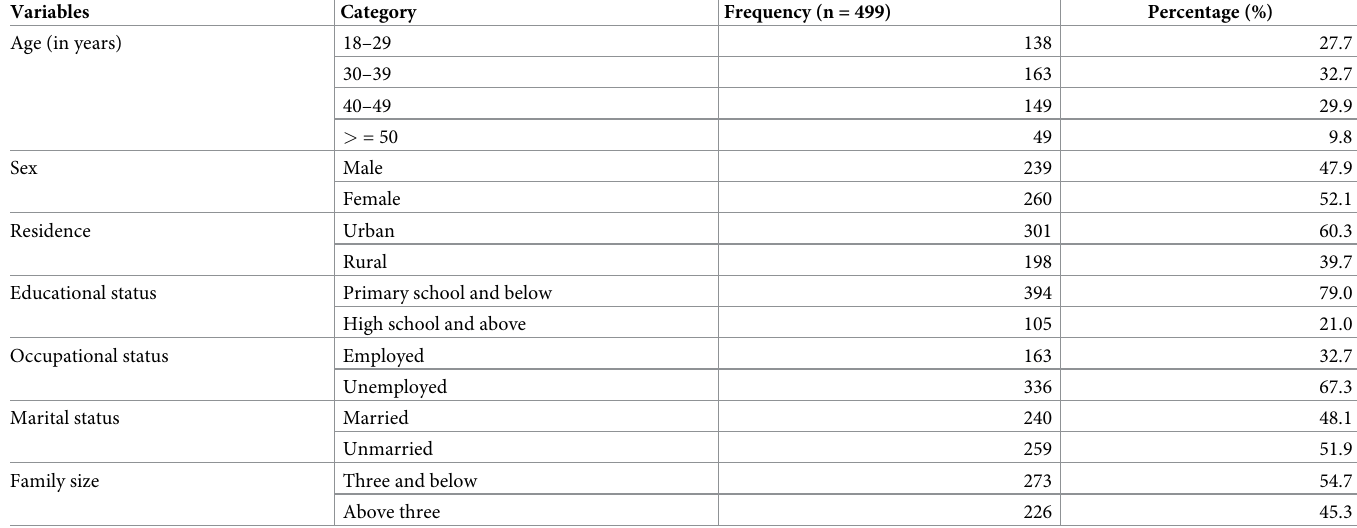
Table 1. Sociodemographic characteristics of HIV positive patients taking ART at Mahal Meda Hospital, North Shewa, Ethiopia, 2018 (n =